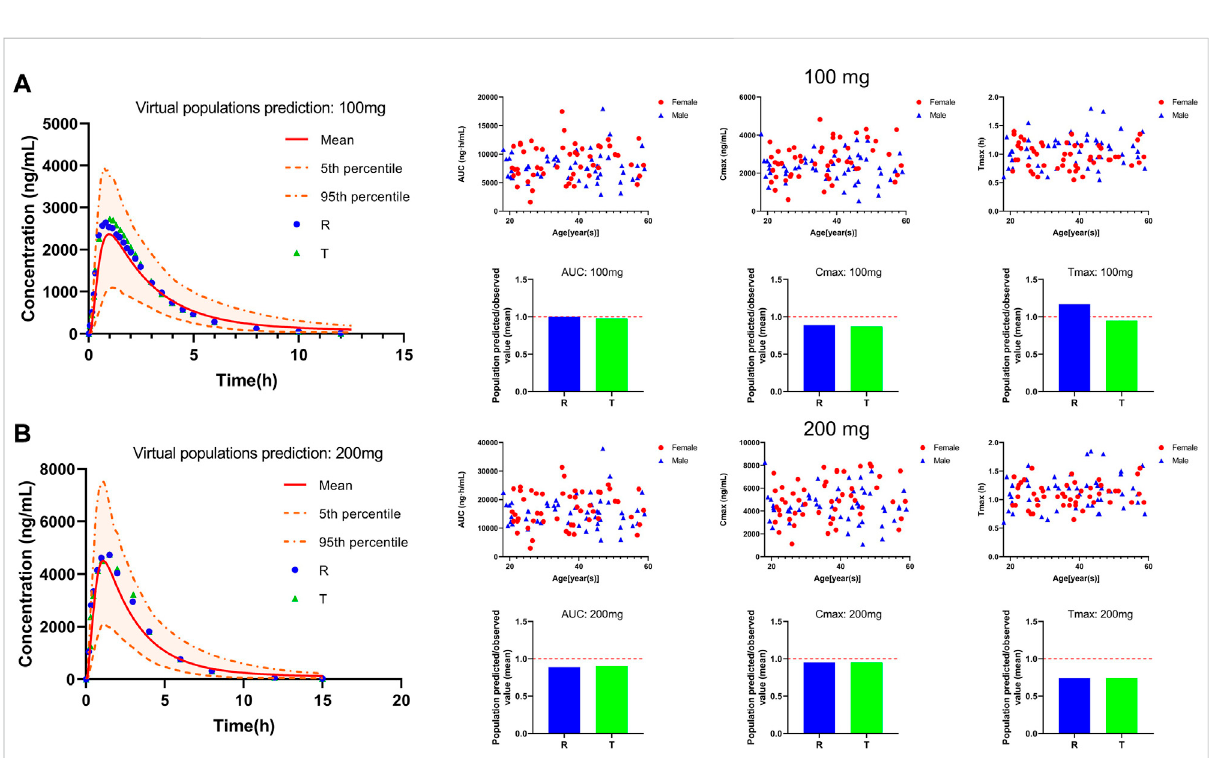
FIGURE 5 PTU 100 and 200 mg virtual adult population PBPK model validation. (A) 100 mg plasma concentration-time curve and pharmacokinetic parameters information. (B) 200 mg plasma concentration-time curve and pharmacokinetic parameters information. Red solid line: predicted population mean curve, yellow dashed lines and areas: 95th and fi fth percentile predicted values and 90% CI of predicted